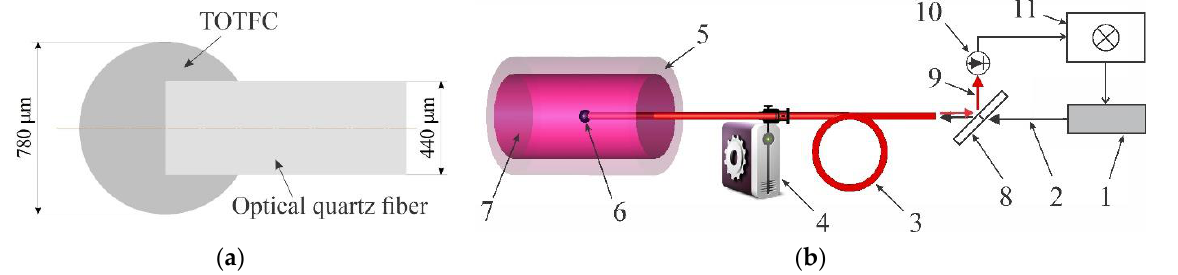
Figure 1. Model of a titanium–containing optothermal fiber converter ( a ) and a scheme explaining the EVLT model ( b ). 1—laser, 2—laser radiation, 3—optical quartz fiber, 4—fiber moving device, 5—vein wall, 6—TOTFC, 7—blood, 8—beamsplitter, 9—thermal radiation (IR signal), 10—photodetector, 11—laser control system.